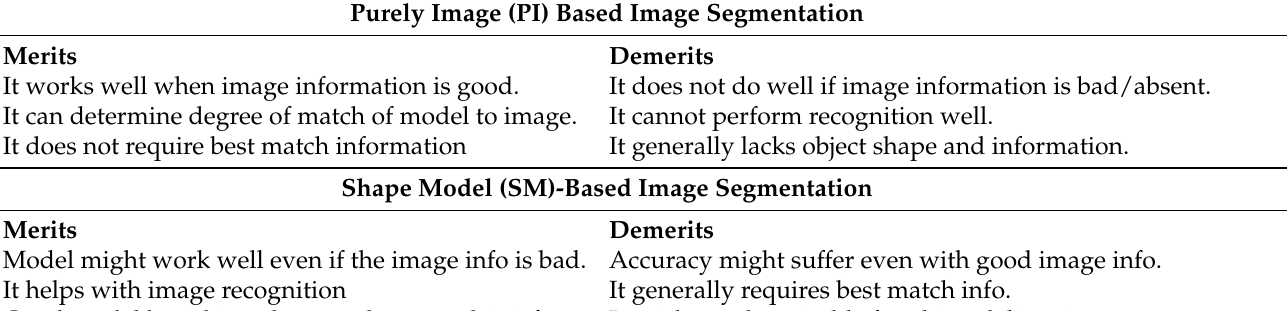
Table 1. Comparison between PI and SM based image